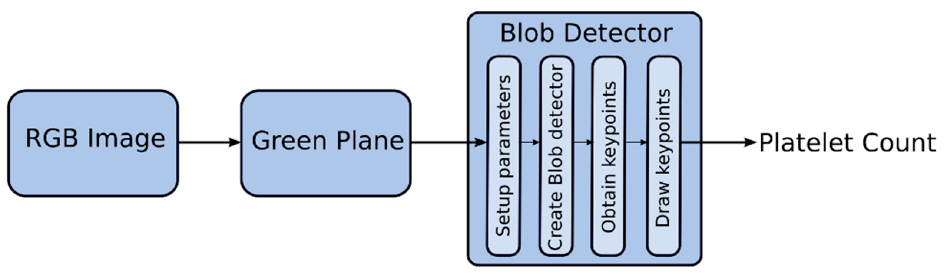
Figure 4. Sequence in the Blob detection algorithm.